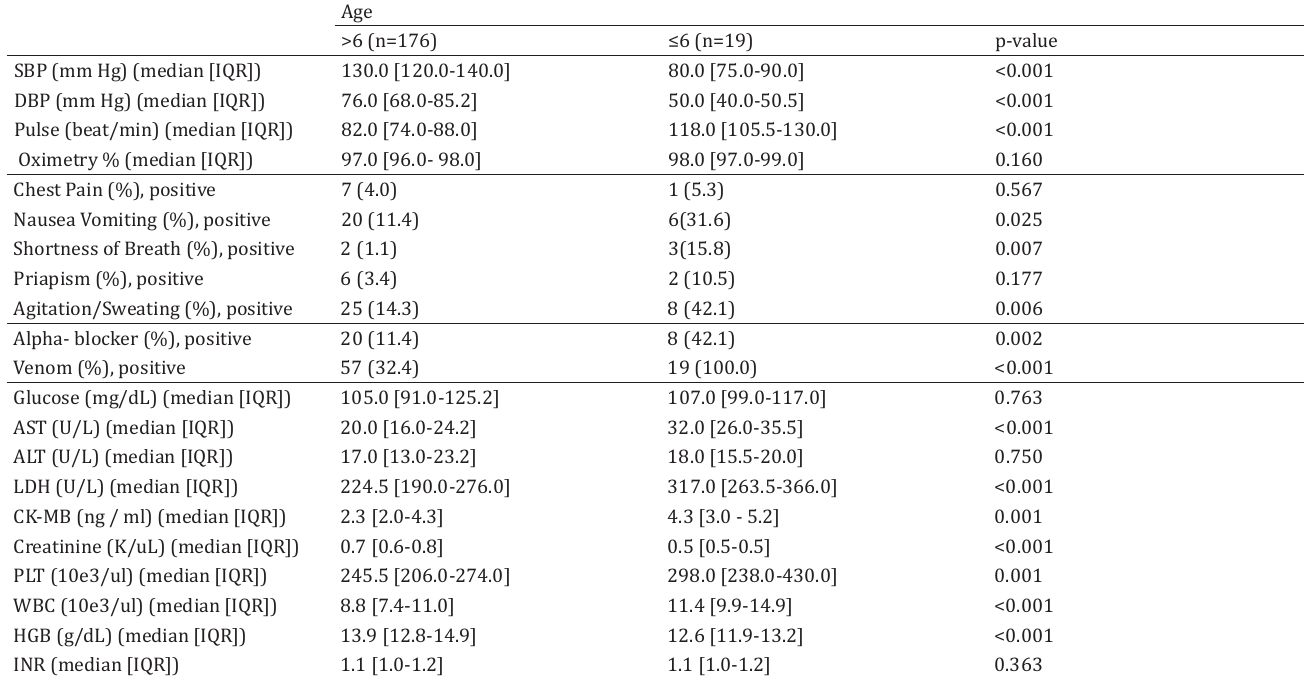
Comparison of some of the vital parameters, emergent complications, administered treatments, and laboratory parameters by the age